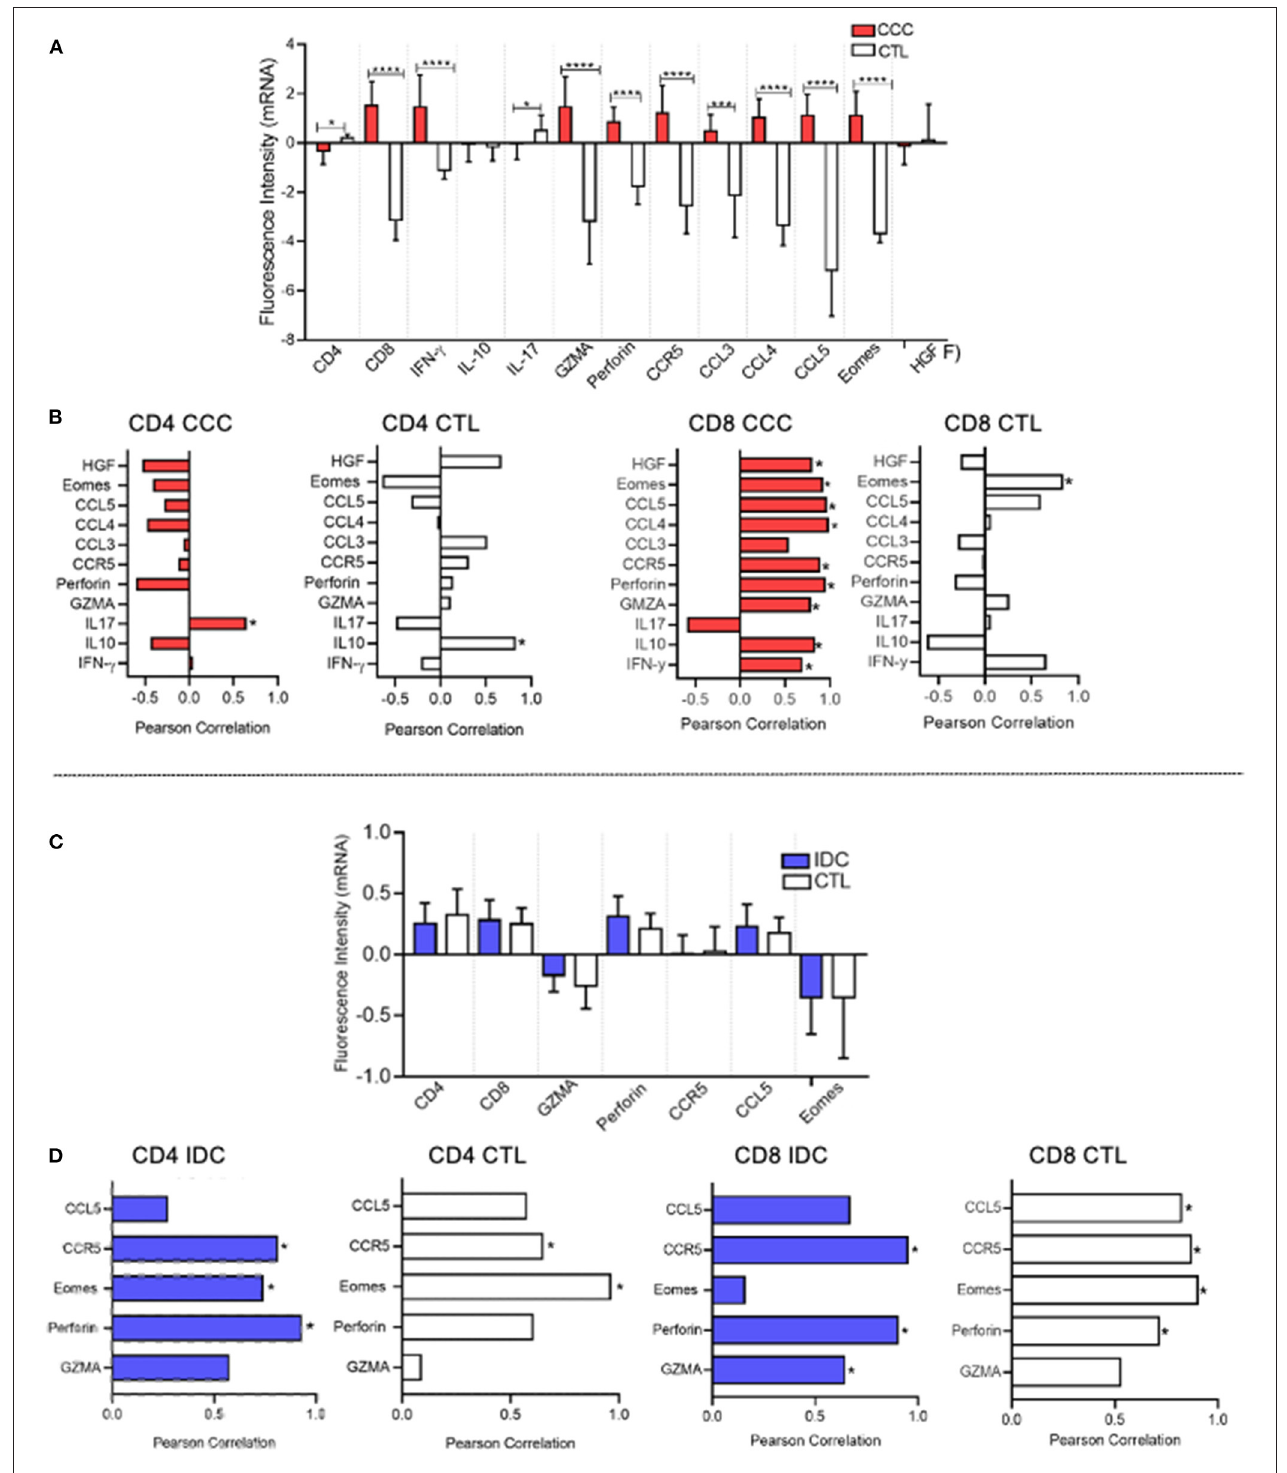
FIGURE 7 | In silico analysis shows association between CD8 and CD4 mRNA with cytotoxic molecules in CCC and IDC hearts, respectively. (A) In silico comparative analysis between the expression of gene transcripts of molecules related to the function of CD4 + and CD8 + cells in cardiac tissue samples from patients with chronic Chagas cardiomyopathy (CCC, n = 10) and healthy donors (CTL, n = 7) (B) Correlation analysis between the intensity of CD8 and CD4 mRNA expression and functional molecules associated with inflammatory, regulatory, cytotoxic, and cardiotropic function in the CCC and CTL group. (C) Comparative analysis between the expression of gene transcripts of molecules related to the function of CD4 + and CD8 + cells in cardiac tissue samples from patients with